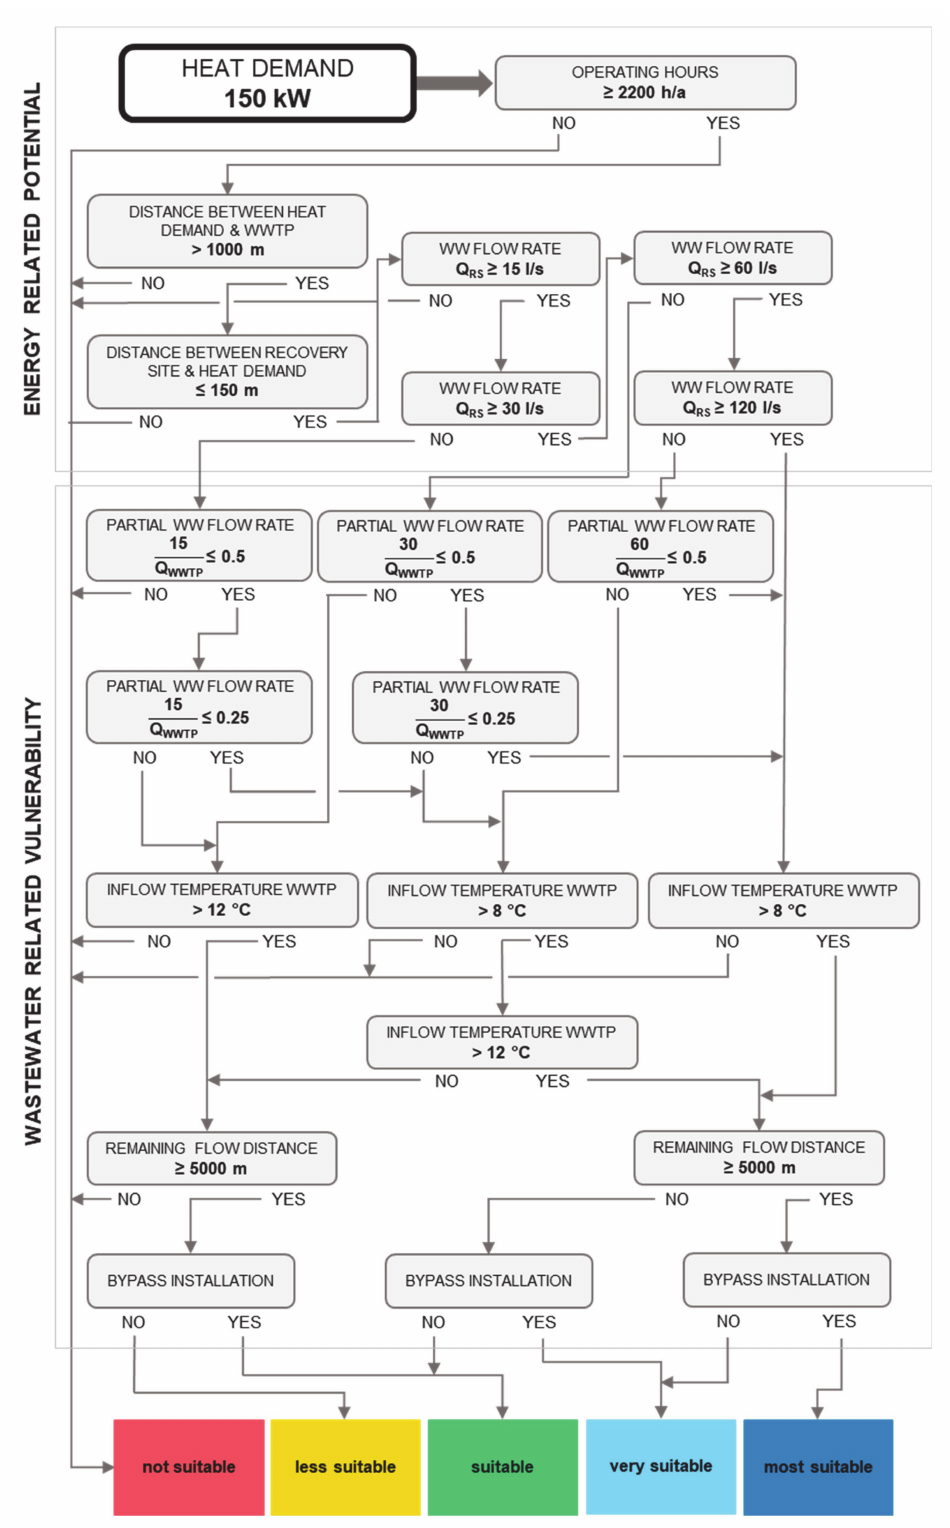
Figure A3. Relevance tree for an intended heat supply of 150 kW (own representation, based on